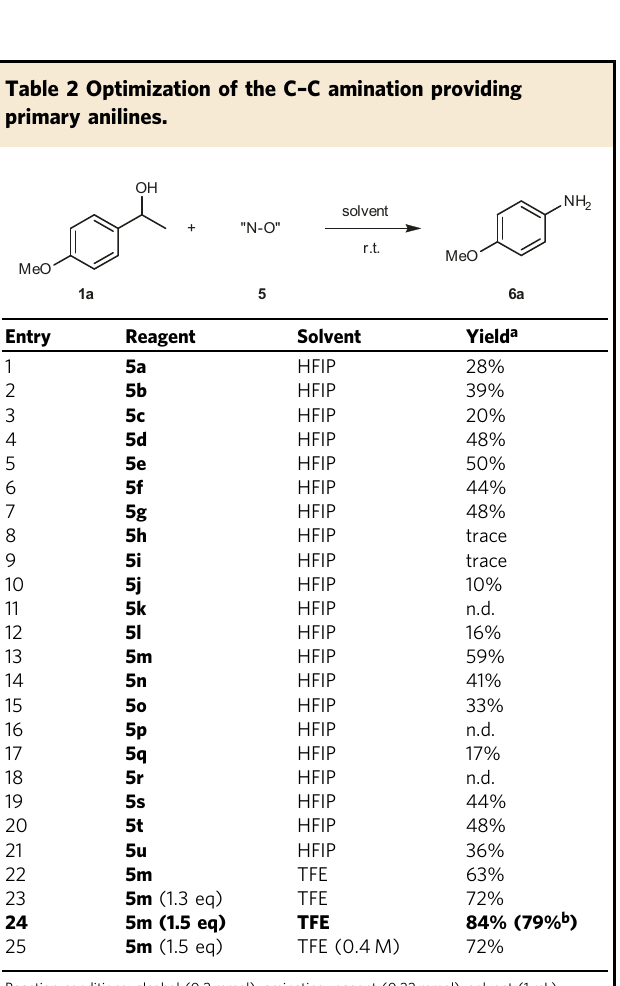
Fig. 4 Hydroxylamine derivatives used for the synthesis of primary anilines. Boc tert -butyloxycarbonyl, Piv pivaloyl, Ms methanesulfonyl, Ts toluenesulfonyl, Tf tri fl